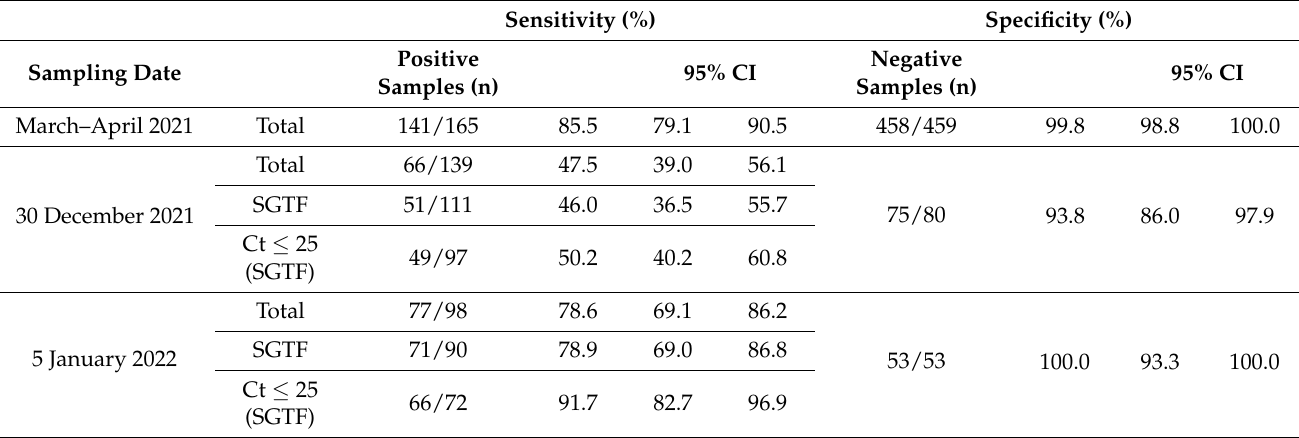
Table 1. Specificity and sensitivity of the test according to Ct values of the